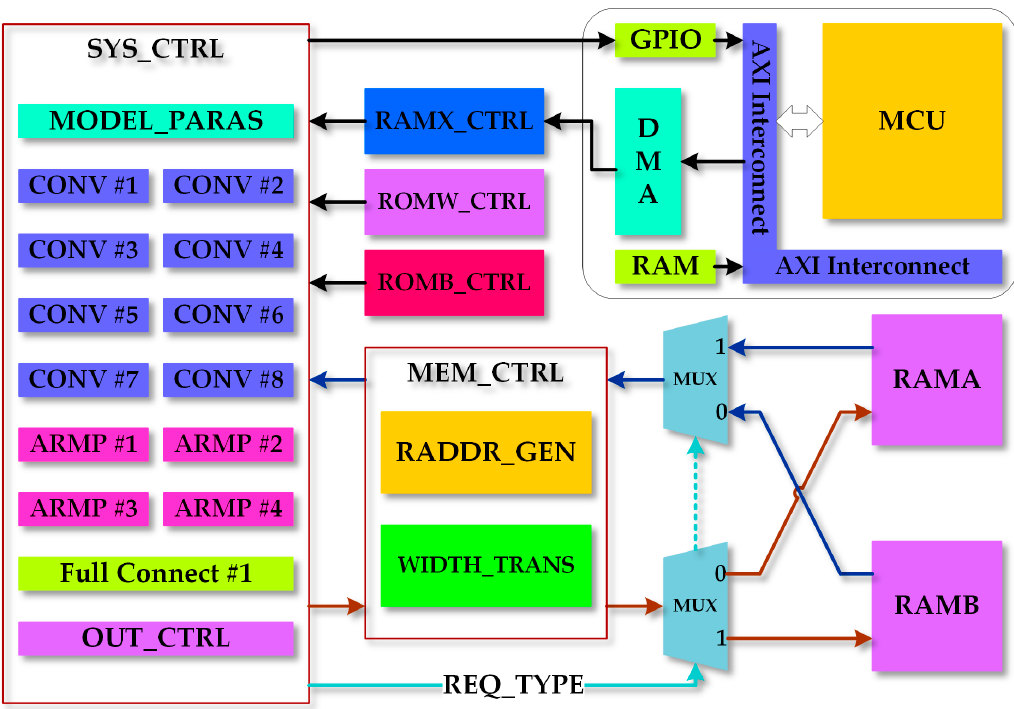
Figure 11. Optimized system architecture. Two blocks of BRAM which form the ping-pong structure simplify the memory access process and reduce unnecessary latency.